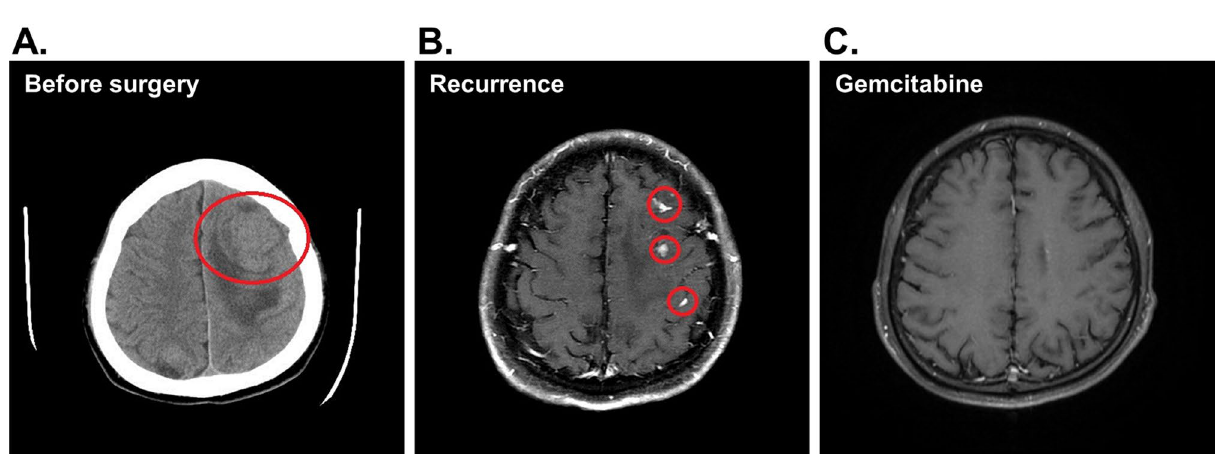
Figure 3. Tissue histology and drug response in the PDOs of patient #1. ( A ) H&E staining of the source tumor tissue and organoid tissue sections. Scale bar, 25 μm. ( B ) The sections were stained by immunohistochemistry for glial fibrillary acidic protein (anti-GFAP). Scale bar, 25 μm. ( C ) The PDOs were treated with temozolomide at the indicated doses converted from the clinical range. The response to the treatment was determined by BrdU incorporation assay measuring DNA replication and normalized by the dimensions of the organoids (in diameter). ( D ) PDOs were treated with vemurafenib (490 μM), dabrafenib (144 μM), trametinib (812 nM), or the indicated combinations. The response to the treatment was determined by BrdU incorporation and normalized by the dimensions of the organoids (in diameter).